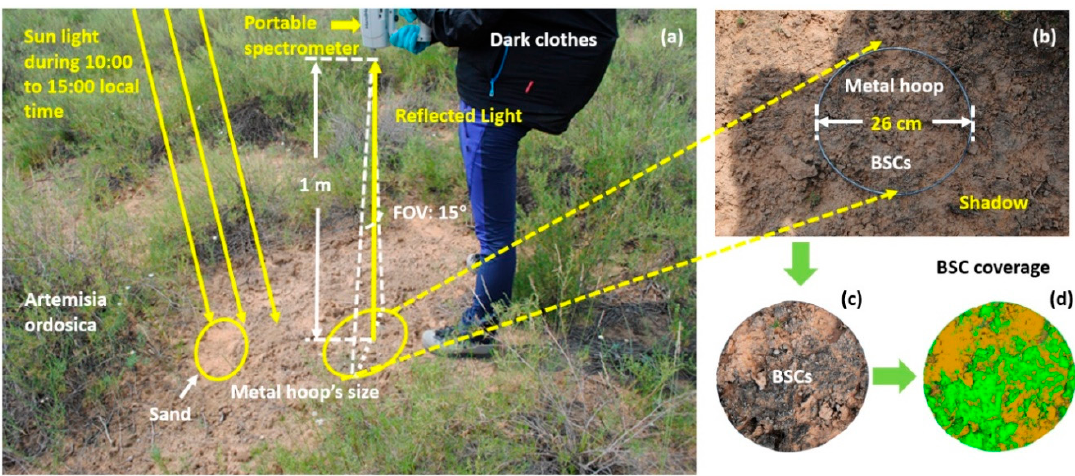
Figure 2. ( a ) Undertaking ground spectral measurements. ( b ) Digital photo of a metal hoop in the shade (for digital photo analysis of biological soil crust (BSC) coverage). ( c ) Clipped photo of a metal hoop. ( d ) Analysis of BSC cover.